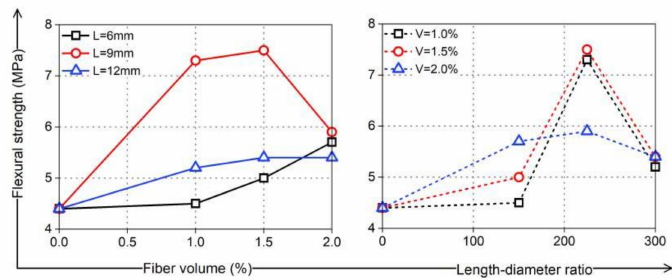
Figure 12. Flexural strength of PVA-reinforced coral cement-based composites.